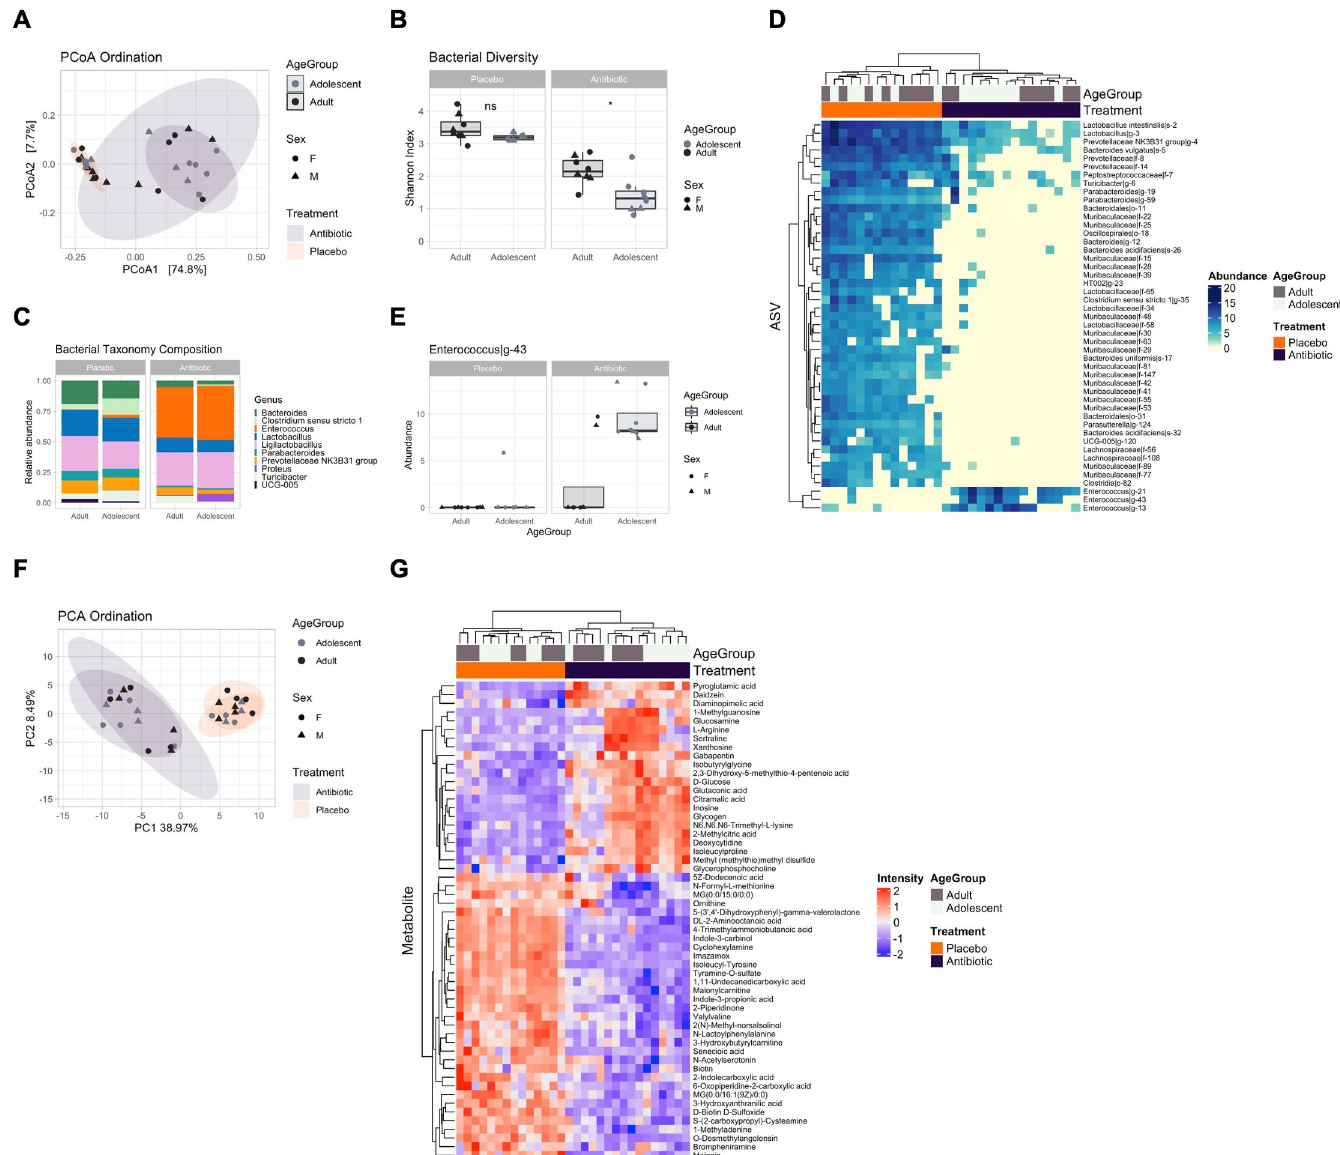
Fig 4. Short-term impact of antibiotics on adolescent and adult microbial and metabolomic profiles. (A) Principal coordinate analysis (PCoA) showing bacterial ordination by age group and treatment at day 17. (B) Bacterial Shannon diversity boxplots, and (C) Taxonomy composition barplots, comparing treatment and age groups at day 17. (D) Heatmap of differentially abundant ASVs between treatment groups at day 17. (E) Boxplot, of differentially abundant ASVs between treatment and age groups at day 17. (F) Principal component analysis (PCA) showing metabolomic ordination by age group and treatment at day 17. (G) Heatmap of differentially abundant metabolites between treatment groups at day 17. Boxplots are indicative of median, interquartile range (IQR) (boxes) and 1.5x IQR (whiskers). � , p < 0.05; n. s., not